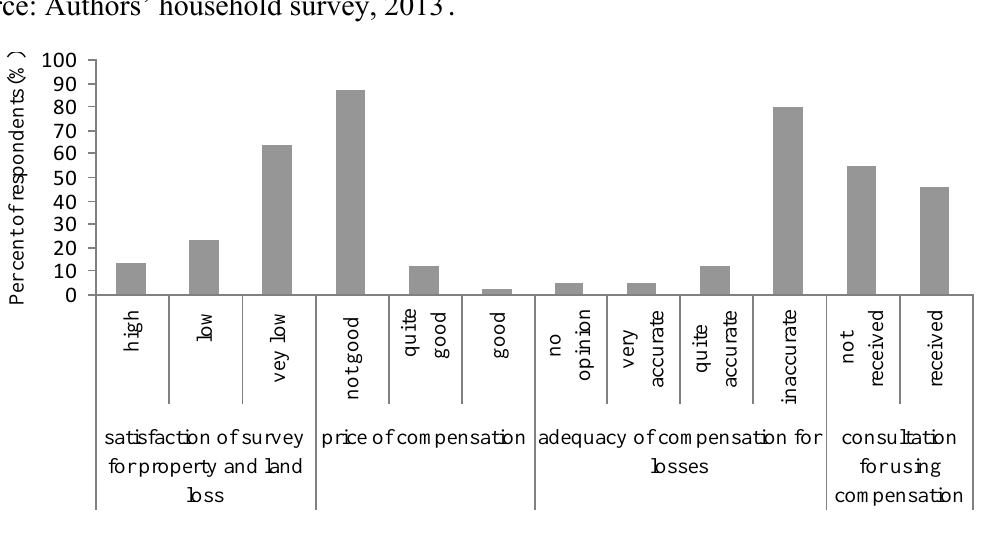
Figure 3. Self-evaluation of respondents on compensation scheme ( n = 60